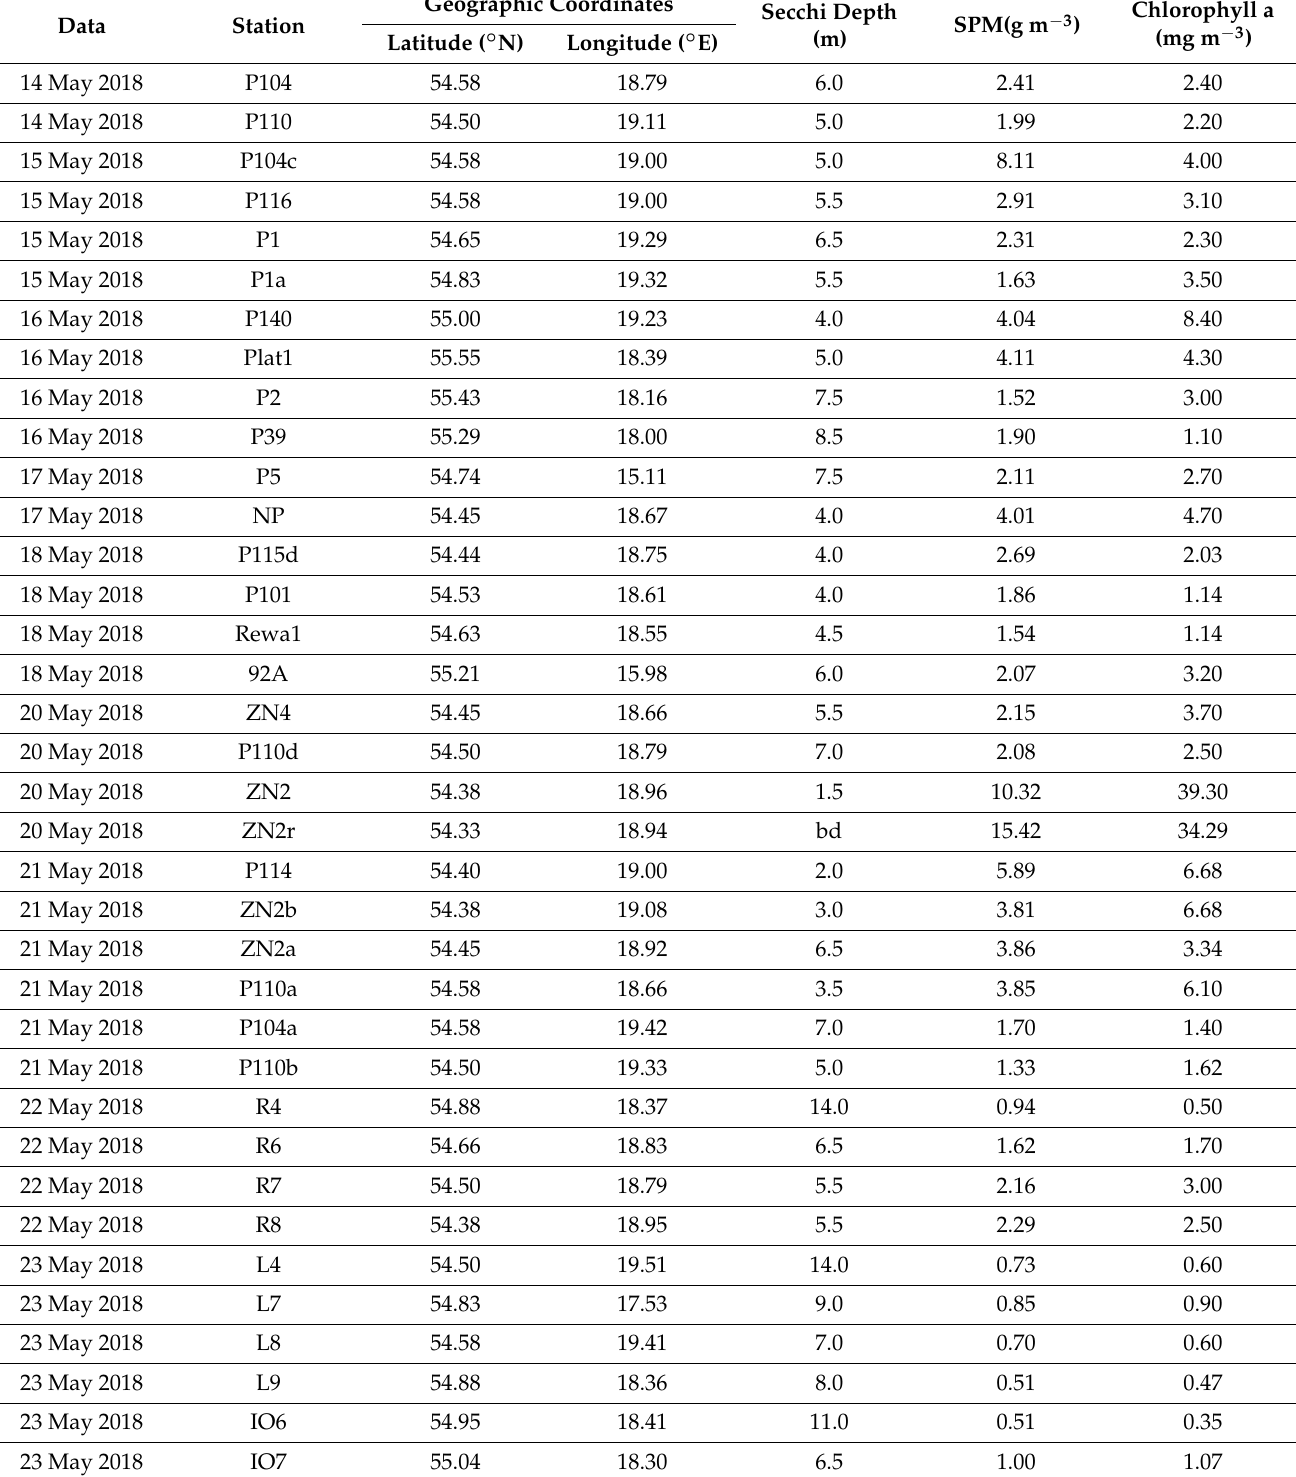
Table 1. Characteristic of sampling stations used in this